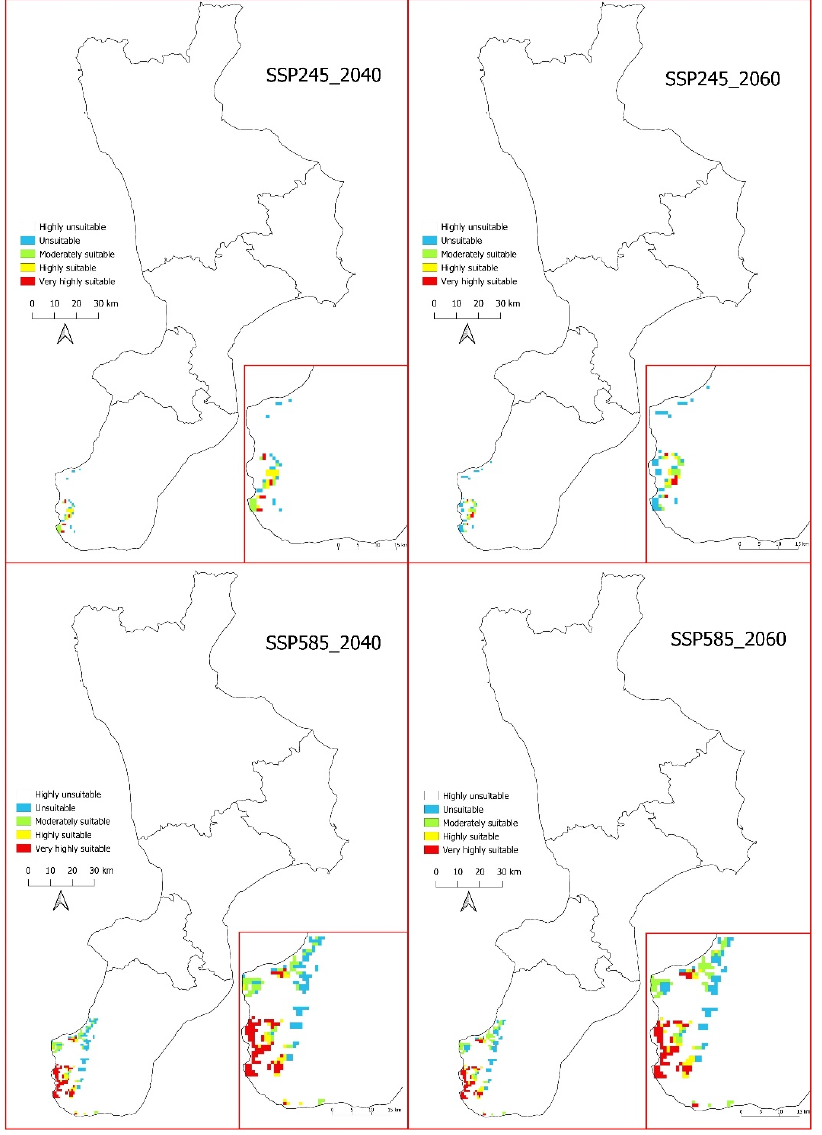
Figure 9. Prediction of the current potential distribution of Salvia ceratophylloides Ard. related to geological substrate, in two different scenarios SSP245 and SSP585 and two periods 2021–2040, 2041–2060. In white, highly unsuitable ( ≤ 0.20); in blue, unsuitable (0.21–0.40); in green, moderately suitable (0.41–0.60); in yellow, highly suitable (0.61–0.80); and in red, very highly suitable ( ≥